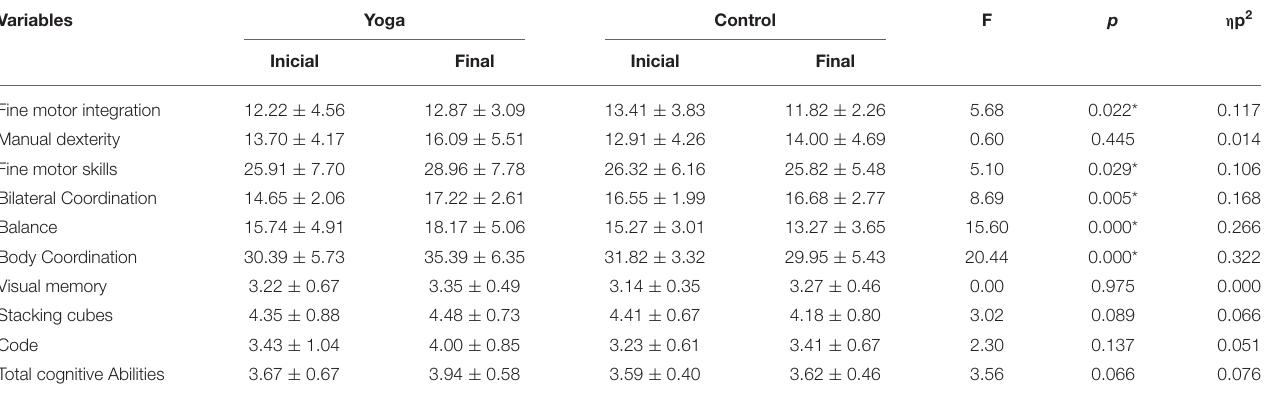
TABLE 2 | SPANOVA (ANOVA goup ×